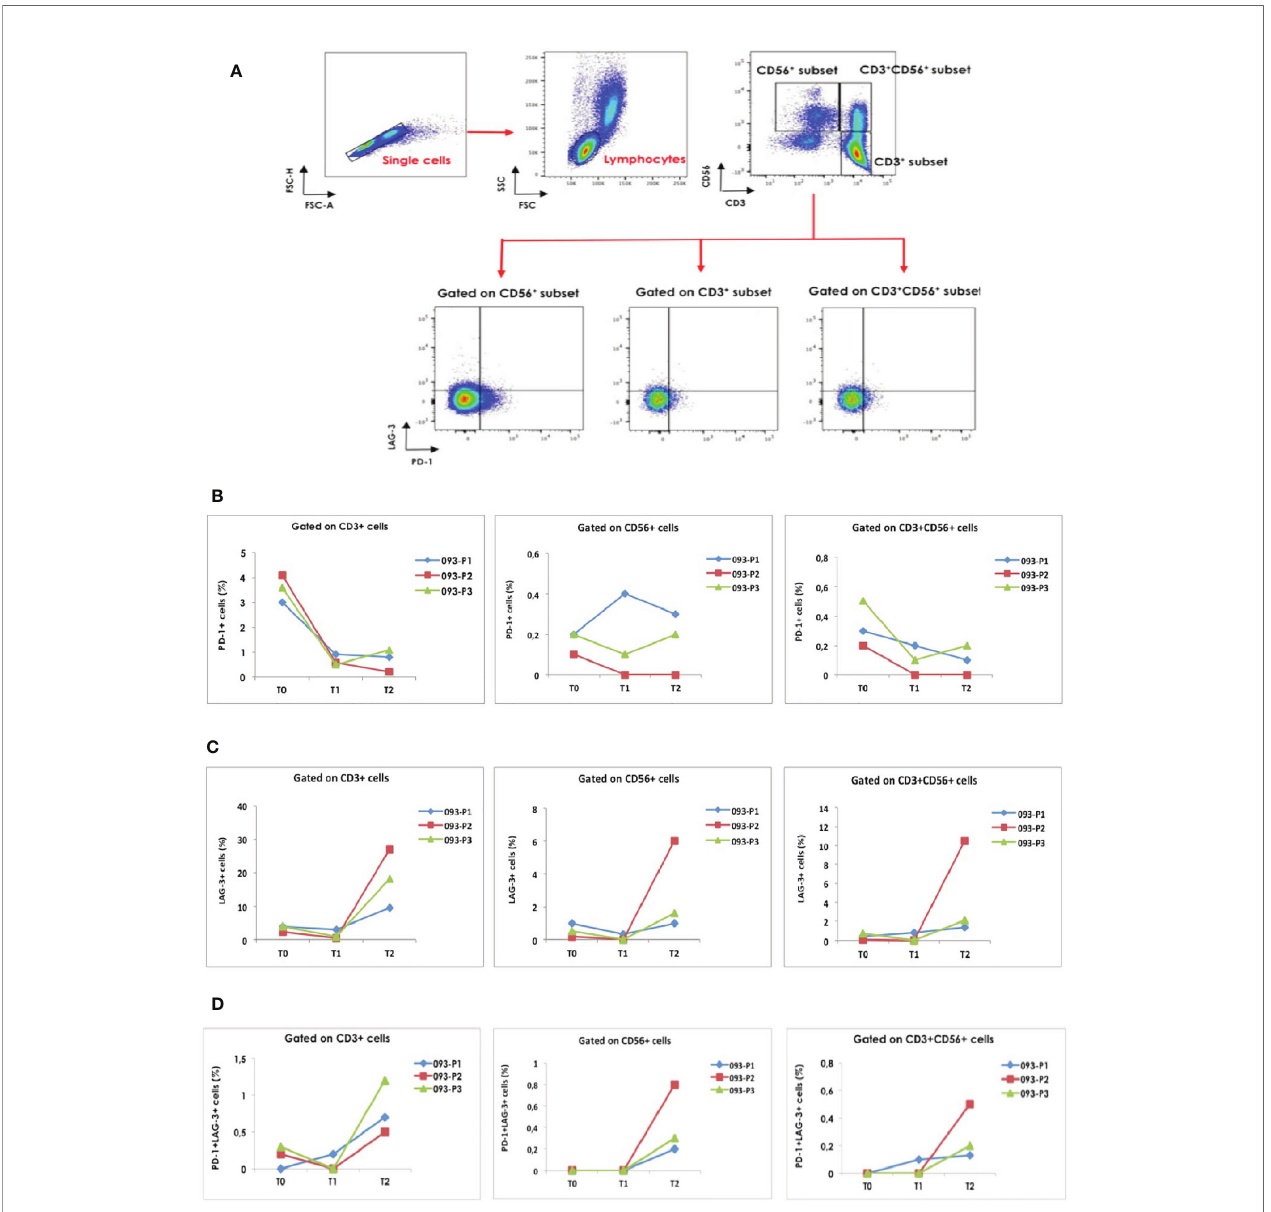
FIGURE 3 | Gating strategy was used to identify (A) , the exhausted CD3 + , CD56 + and CD3 + CD56 + cell subsets by evaluating the expression of PD-1 and LAG-3. Single cells were gated and doublets were excluded. A lymphocyte gate was set in FSC-A and SSC-A plot. The graphs report the changes in (B) , the percentage of exhausted T, NK and NKT cells expressing PD-1, (C) , LAG-3 and (D) , both immune checkpoint molecules in the three clinical cases at T0, T1 and